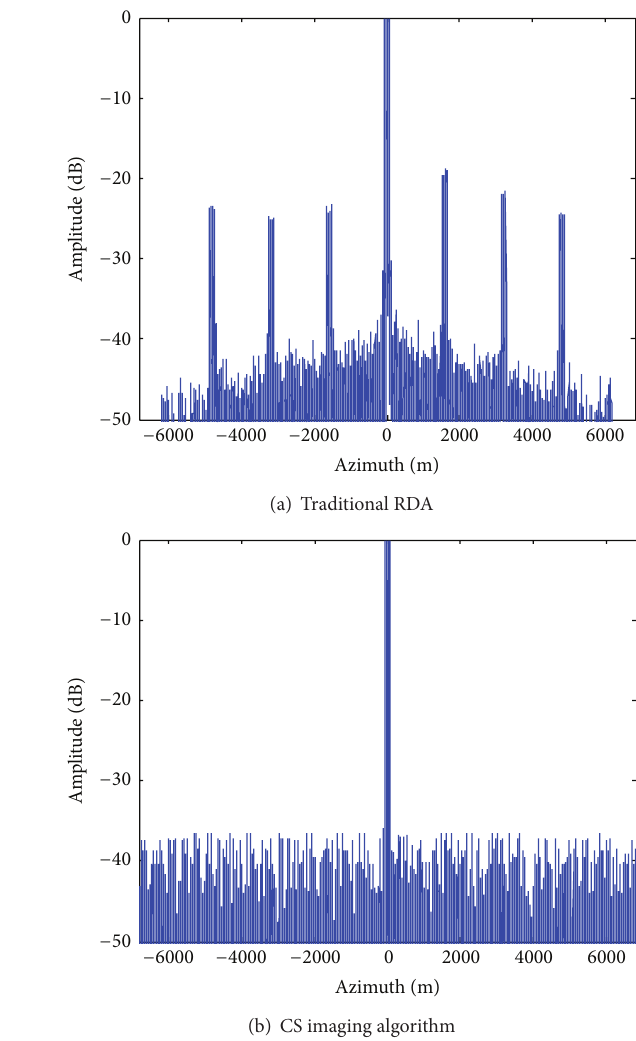
Figure 10: Azimuth slice of imaging results when nonuniform sampling exits in